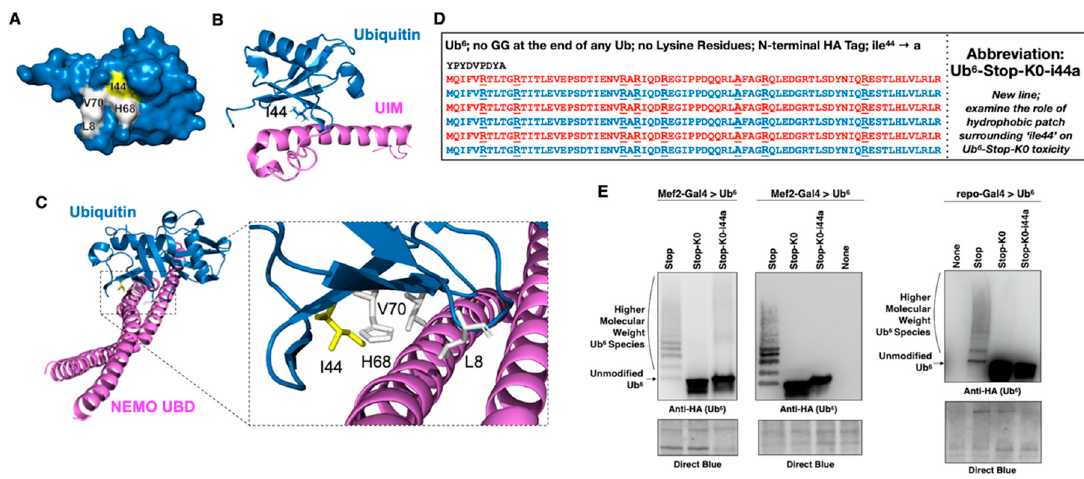
Figure 5. New transgenic, lysine-less ubiquitin chains with mutated isoleucine 44. ( A ) Surface representation of ubiquitin (PDB 1ubq) highlighting the structural location of the amino acids forming the hydrophobic patch involved in ubiquitin recognition (I44 in yellow, and L8, H68, and V70 in white). ( B , C ) Ribbon representation of ubiquitin (blue) displaying isoleucine 44 in the binding surface of different ubiquitin-interacting motifs in pink. ( B , UIM; PDB 1yx5; C , the UBD domain of NEMO; PDB 2zvo). Inset highlights ubiquitin’s hydrophobic patch and the key position of isoleucine 44 (yellow). Images were generated using PyMol (Schrodinger, Inc., New York, NY, USA). ( D ) Summary of the new ile44a transgenic line that we generated, its abbreviation and purpose. ( E ) Western blots from flies expressing the noted transgenes in all muscle cells (Mef2-Gal4, adult lysates) or all glial cells (repo-Gal4, pharate adult